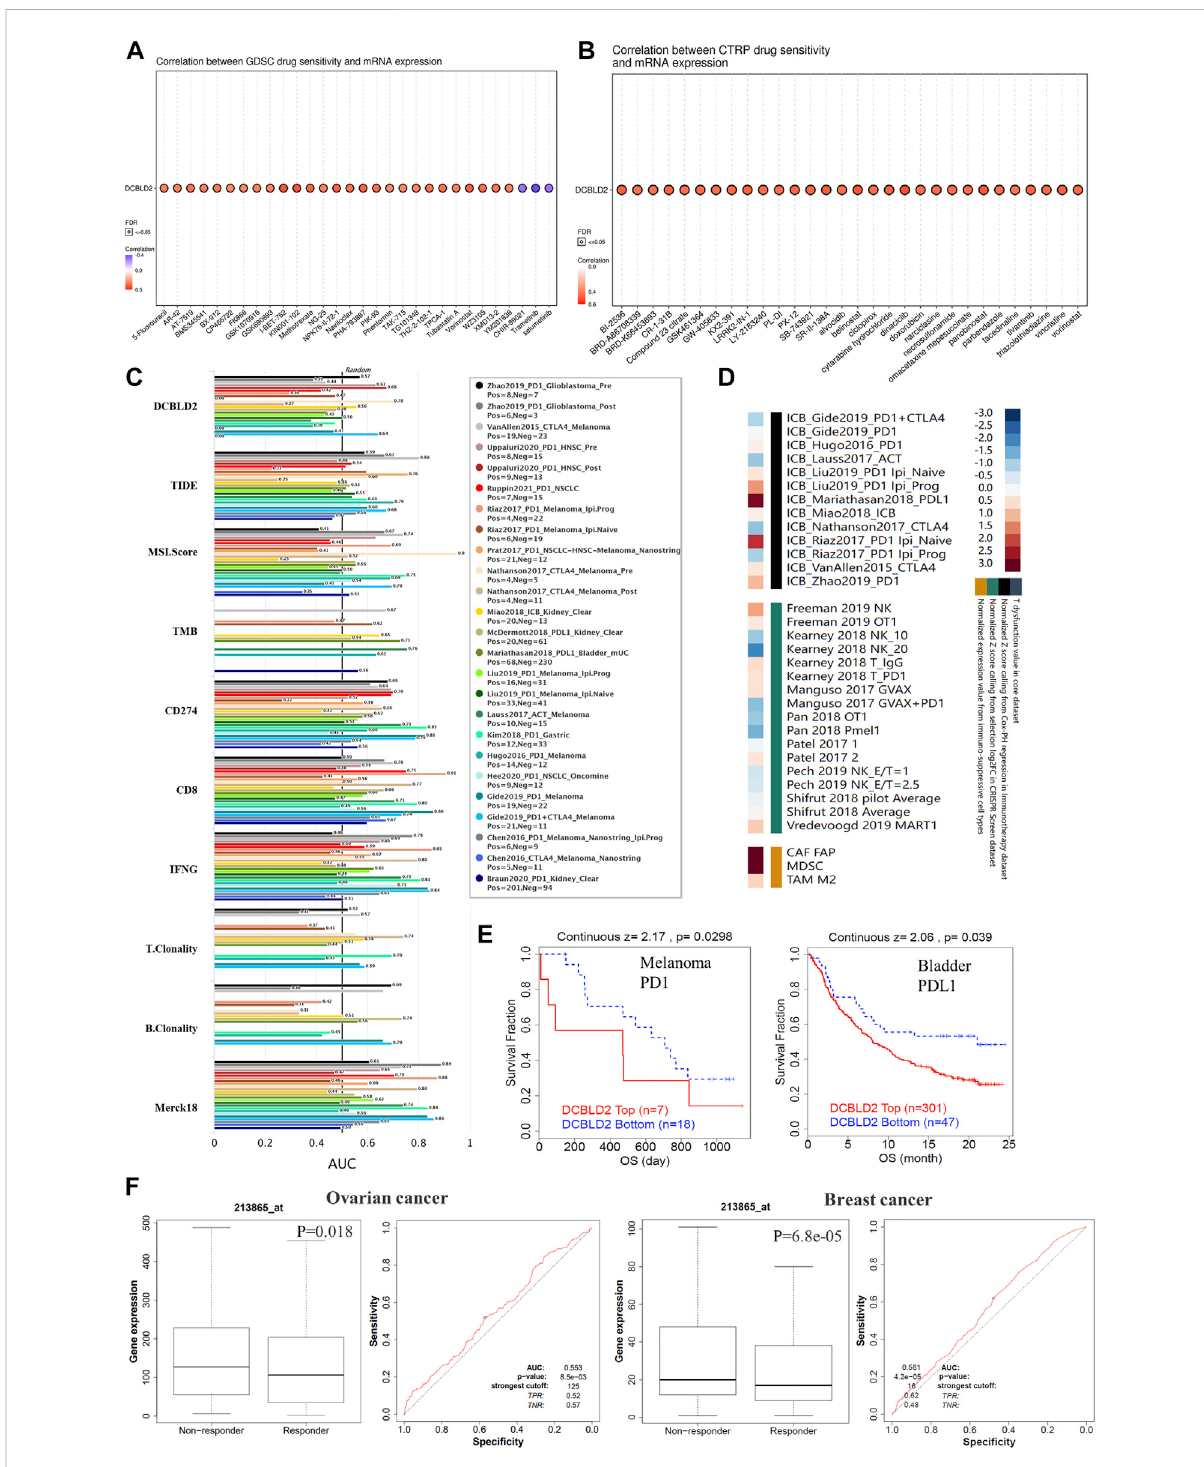
FIGURE 6 Association of DCBLD2 expression with therapeutic responses. (A,B) A bubble chart showing the association between DCBLD2 expression and IC50 value of multiple drugs in solid tumor cells, acquired from the GDSC database (A) and CTRP database (B) . The color of bubbles showing the correlation coef fi cient between DCBLD2 expression level and IC50 value. The points coiled by black contours indicate that FDR < 0.05. (C) The bar chart showing the difference in the ef fi cacy of DCBLD2 and standardized cancer immune evasion biomarkers in various data sets of tumor patients receiving immunotherapy. The ef fi cacy was evaluated by the area under the receiver operating characteristic curve (AUC). (D) Heat maps showing the correlation between DCBLD2 expression levels and outcome in knockout models and tumor patients receiving immunotherapy (E) Effect of DCBLD2 expression on overall survival in melanoma patients treated with PD1 and bladder cancer patients treated with PDL1 (All p < 0.05). (F) Effect of DCBLD2 expression level on chemotherapy sensitivity in breast and ovarian cancer patients and ROC curves (All p <